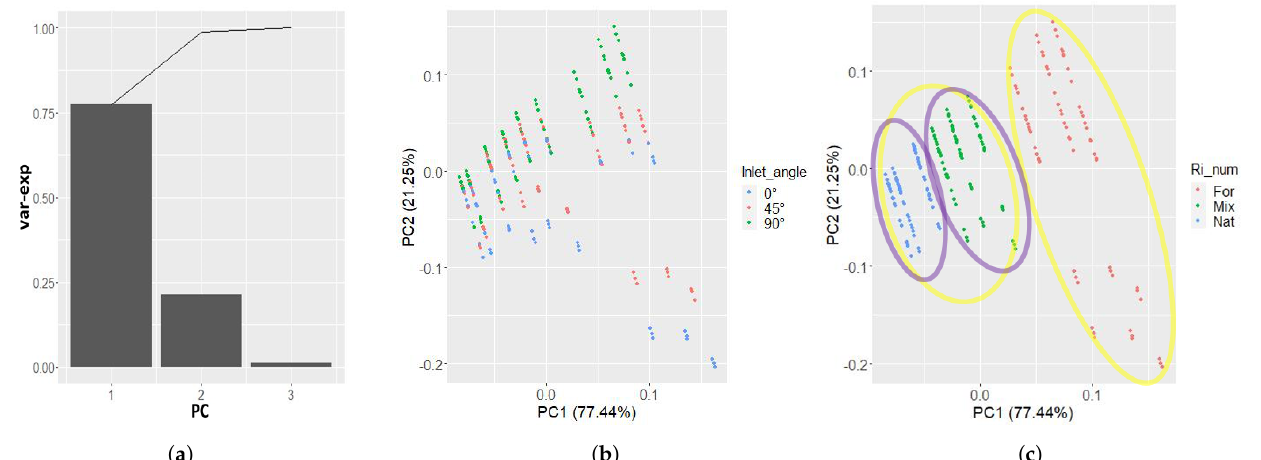
Figure 6. PCA and clustering for the AER of the barn, ( a ) is the percentage of variance explained by the PCs, ( b ) is the datapoints displayed in the first two PCs’ orthogonal system and colored according to the three levels of the inlet angle, ( c ), similar to ( b ), but this time the datapoints are colored with respect to the three different convection types: forced (For), mixed (Mix) and natural (Nat).